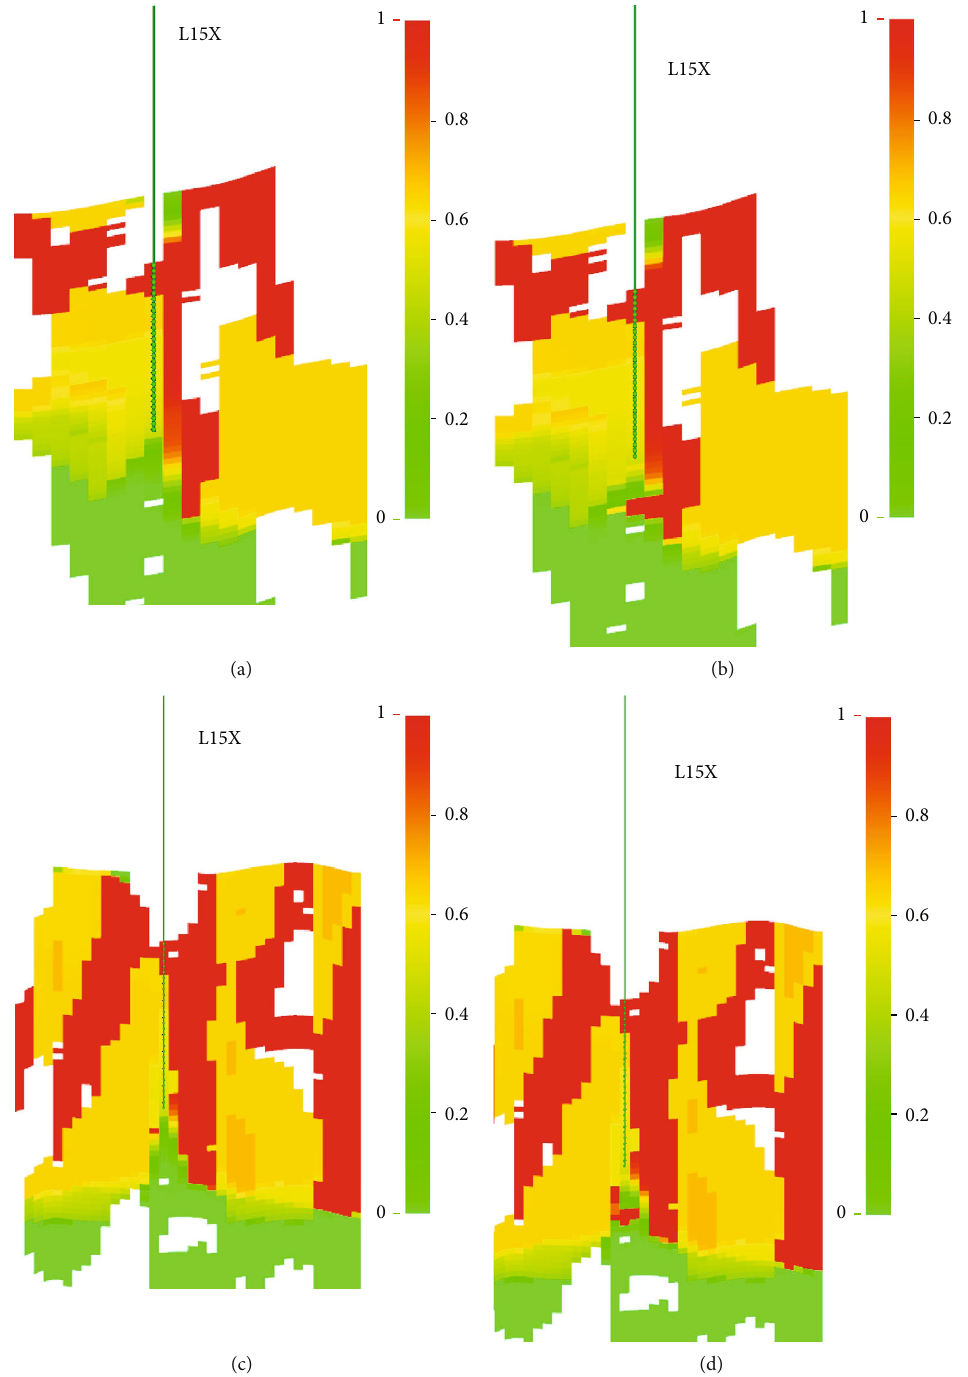
Figure 19: The in fl uence of bottom hole arti fi cial ba ffl e on residual oil